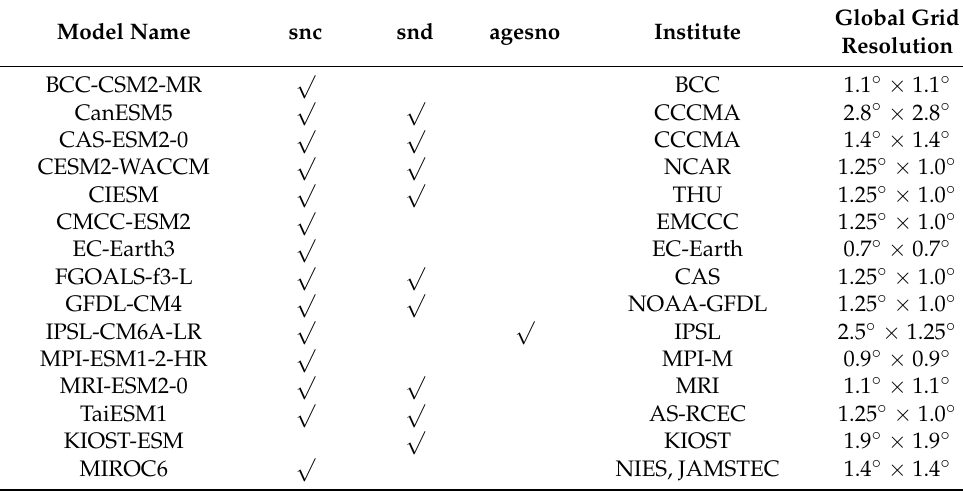
Table 1. The Coupled Model Intercomparison Project (CMIP6) model name, institute, and resolution √ numbers of each model used in this study. represents the model used under each